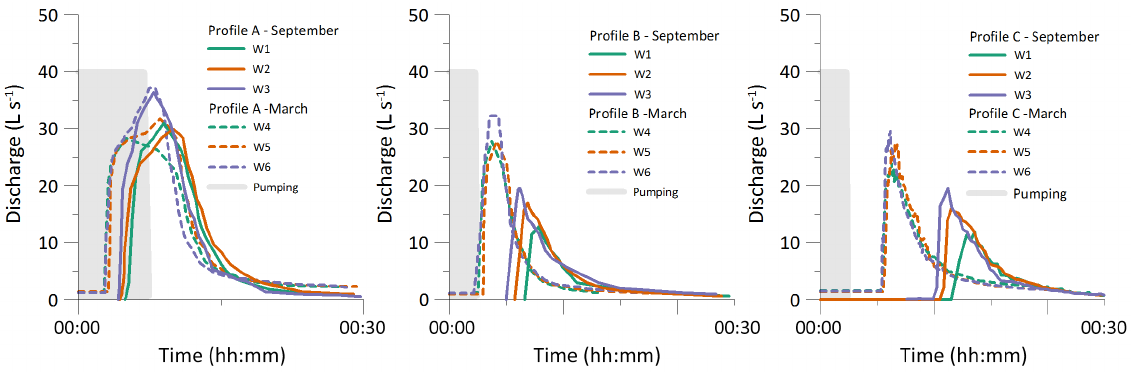
Figure 4. Hydrographs of flood propagation along the monitored stream in the Nuˇcice catchment. The different dynamics in September (W1–W3) and March (W4–W6) are caused by the current state of the stream and the vegetation conditions.